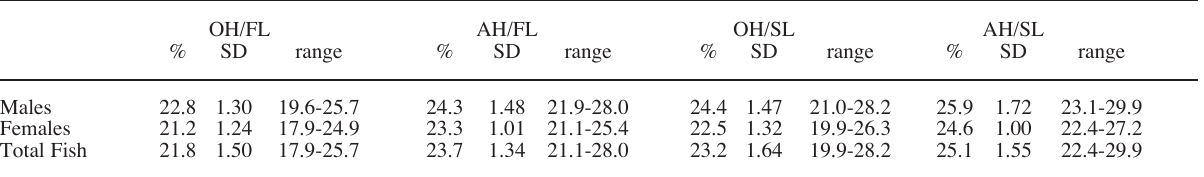
T ABLE 5. – Mean ratio (%), standard deviation (SD) and range in the % ratios, between the fork length (FL) or standard length (SL) and the body height measured at the level of the operculus (OH) or at the anus (AH), in females and males of Coryphaena equiselis